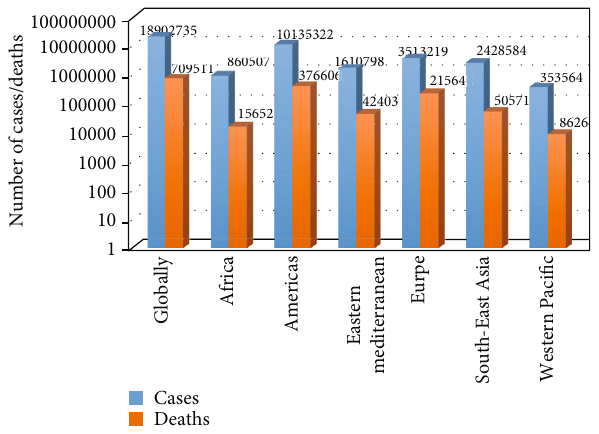
Figure 1: WHO regional number of COVID-19 cases/deaths as of 7 th August, 2020 at 10:00 CEST (logarithmic